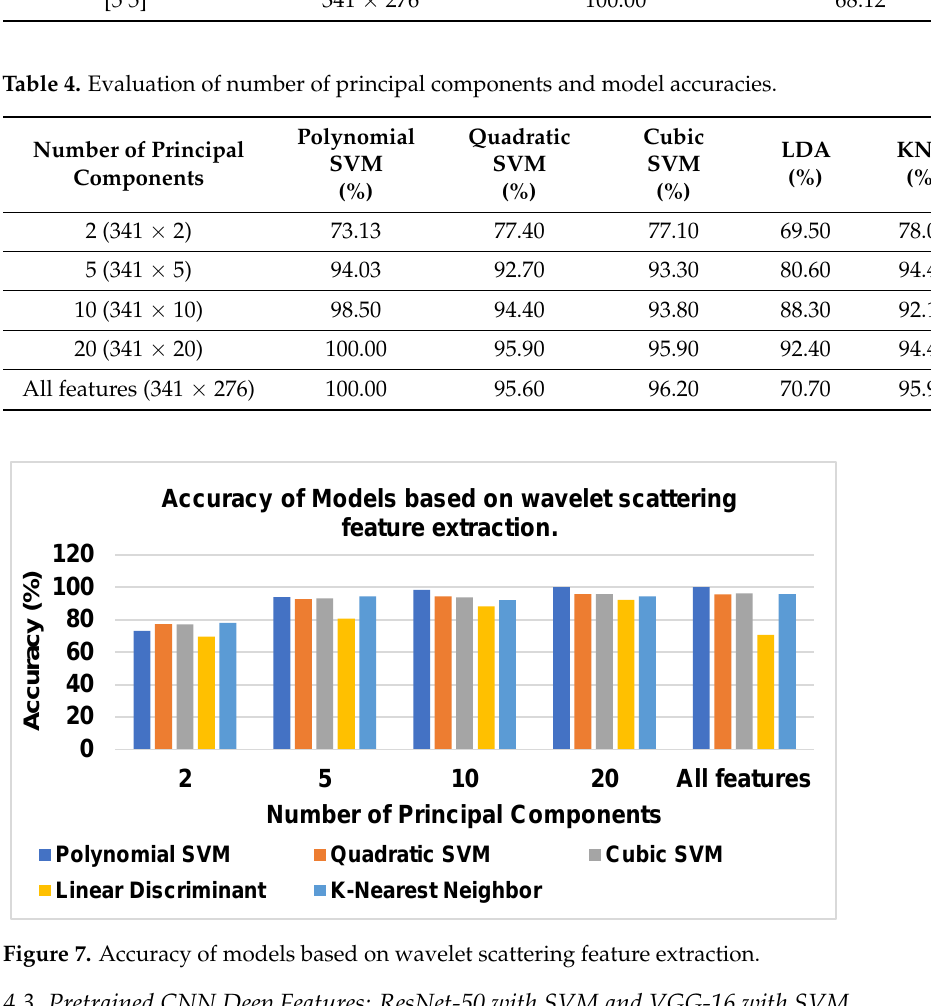
Table 4. Evaluation of number of principal components and model accuracies.